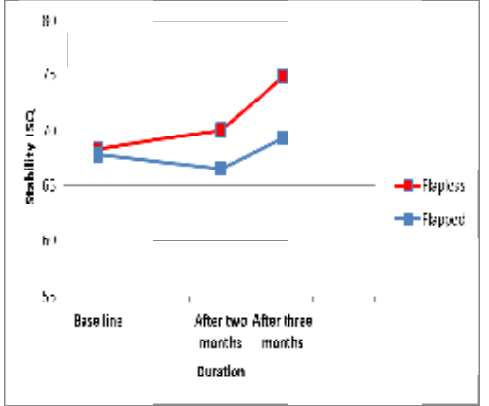
Fig. 6: The mean stability of the dental